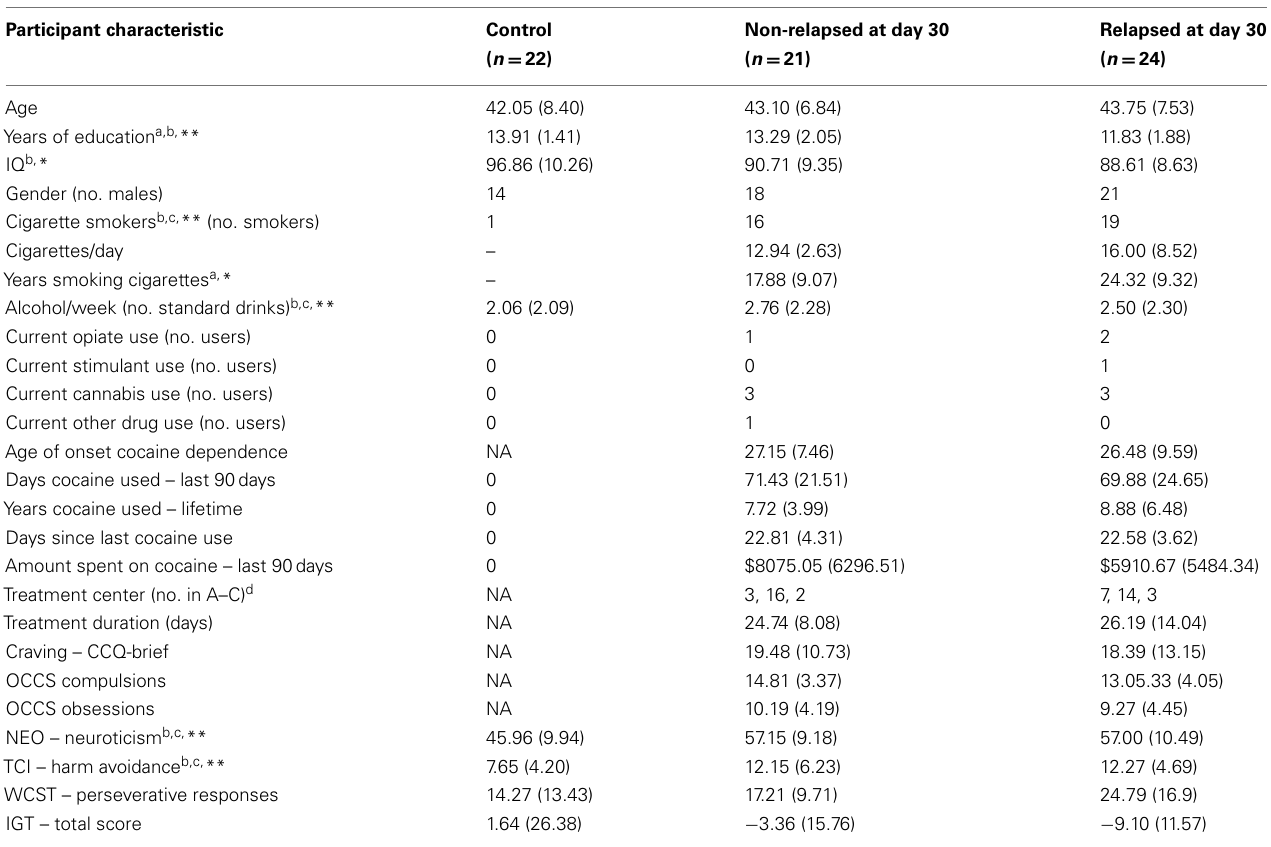
Table 1 | Demographic, drug use, treatment, and behavioral